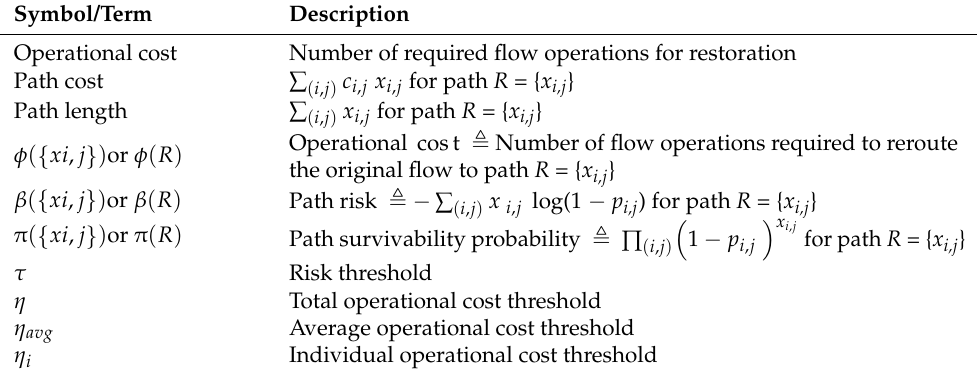
Table 1. Cont. Symbol/Term Description Operational cost Number of required flow operations for